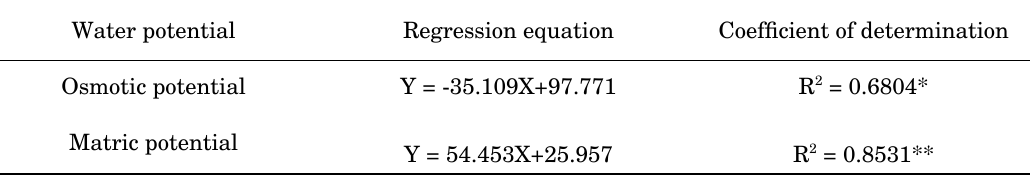
Table 2. Regression equations describing the relation between sclerotial germination (Y) of Macrophomina phaseolina and osmotic and matric potential